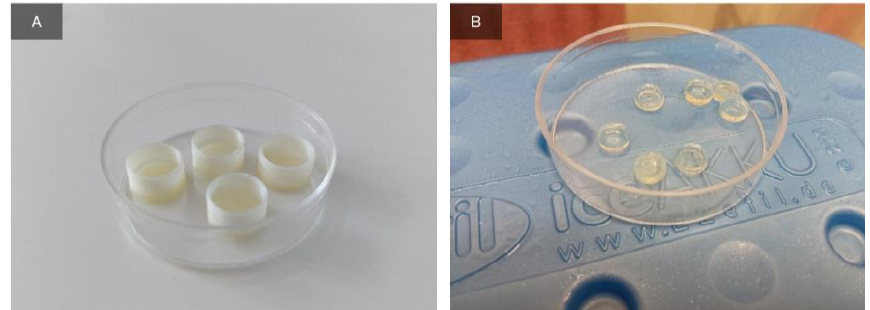
Figure 8. Scaffold preparation for in vivo implantation. Photograph of the printed PLA form ( A ). Scaffolds obtained by molding ( B ).